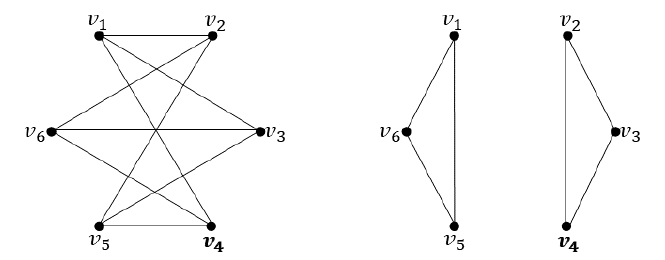
Figure 4. The graph C and its δ -complement C δ